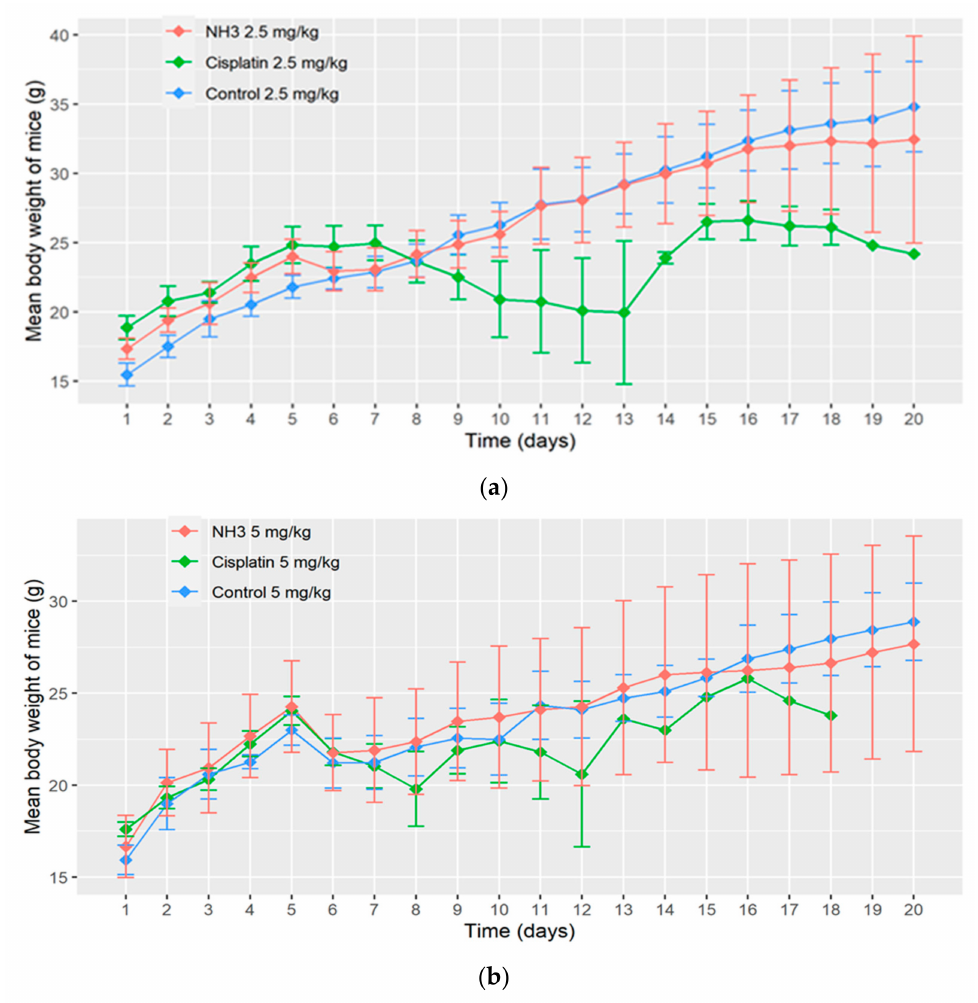
Figure 13. ( a ) Change in body weight of mice in different treatment groups at a dose of 2.5 mg/kg; ( b ) Change in body weight of mice in different treatment groups at a dose of 5